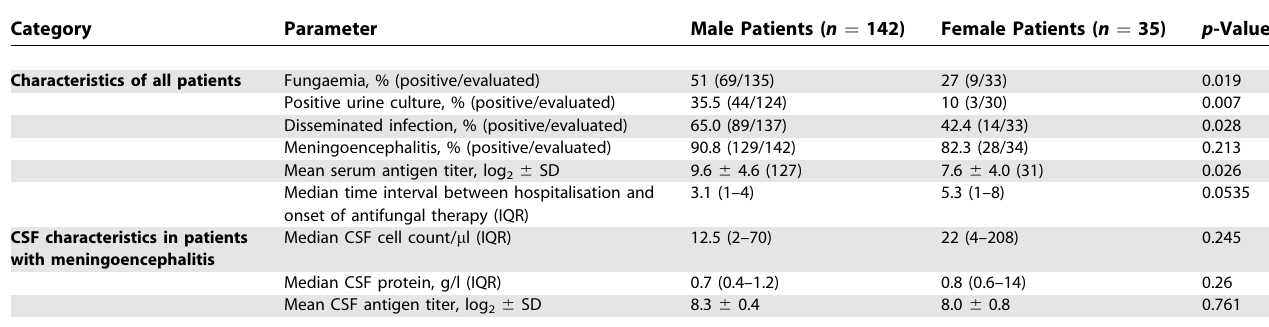
Table 2. Characteristics of Cryptococcosis that Significantly Differed between Sexes in 177 HIV-Infected Patients with